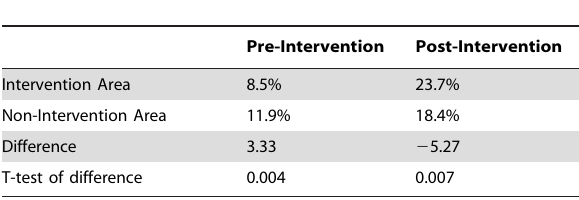
Table 2. Assisted Delivery Rates in Study Districts.